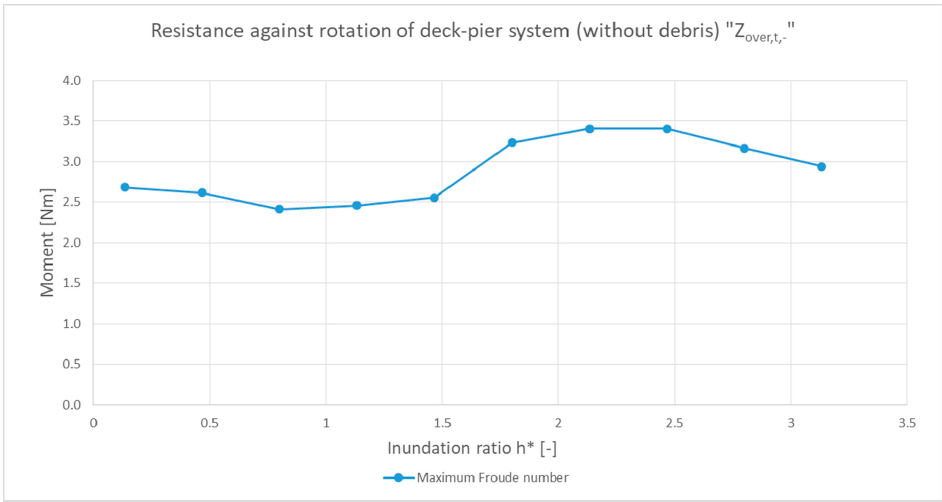
Figure 9. Self-weight restoring moment of the deck-pier system (about the heel of the pier) minus the hydrodynamic overturning moment, as measured by the load cell.